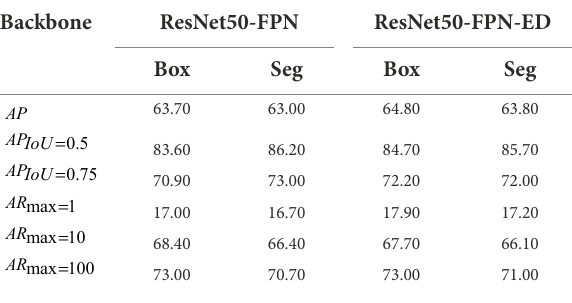
TABLE 8 Comparison of test results with different backbones based on dataset Grape-A.